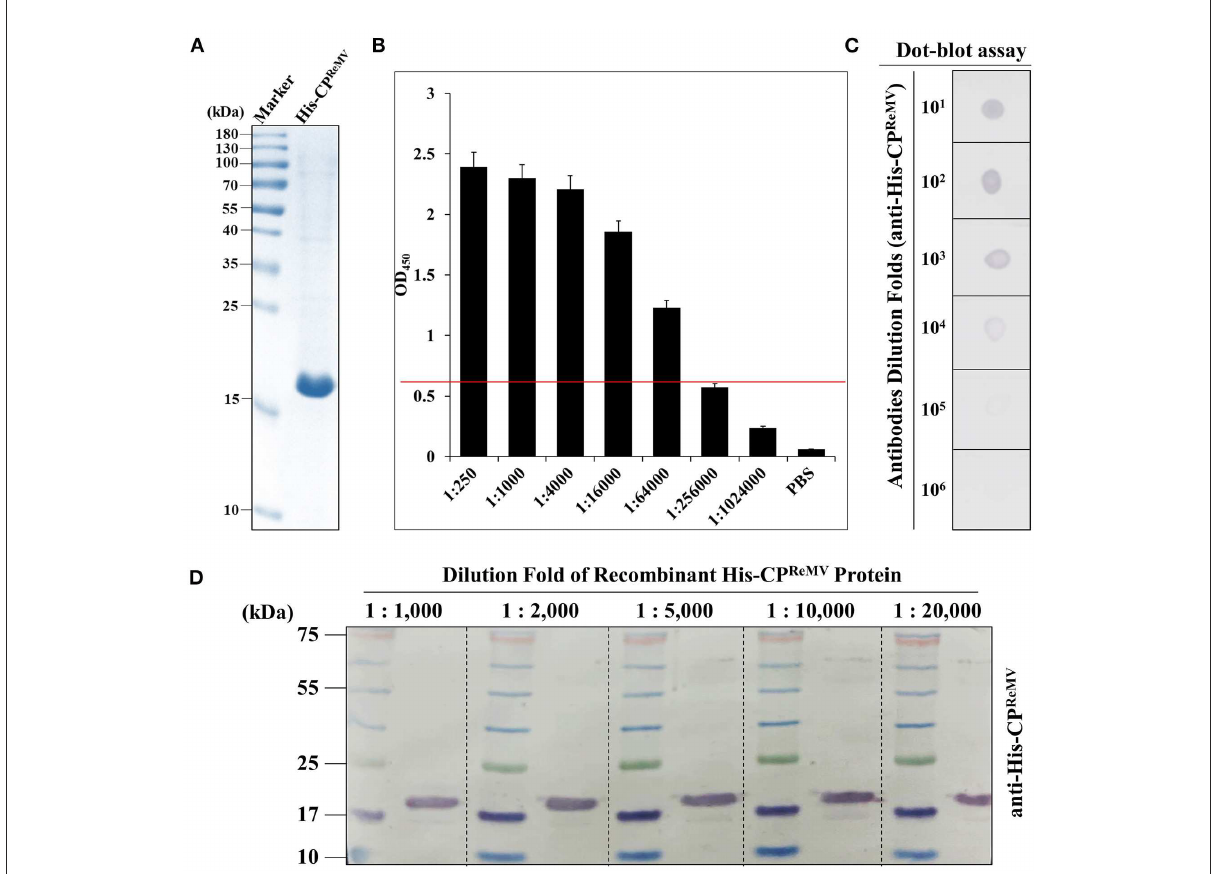
FIGURE2 Evaluation of the quality of the prepared antiserum against the His-CP ReMV protein using three serological methods. (A) SDS-PAGE analysis of the dialyzed His-CP ReMV protein purified by affinity column. (B) The titer of the crude antiserum was determined by enzyme linked immunosorbent assay (ELISA), using commercial horseradish peroxidase (HRP)-labeled as secondary antibody. The X-axis shows the antiserum dilutions folds that using phosphate buffer solution (PBS). Y-axis shows the absorbance values measured at 450nm. M stands for the protein markers. (C) The crude antiserum was evaluated by Immuno-dot-blot assay by diluted for different folds by PBS. The purified His-CP ReMV was taken as antigen. (D) Evaluation of the crude antiserum by western blot assays. The crude antiserum was diluted for different folds by PBS, and purified His-CP ReMV was taken as